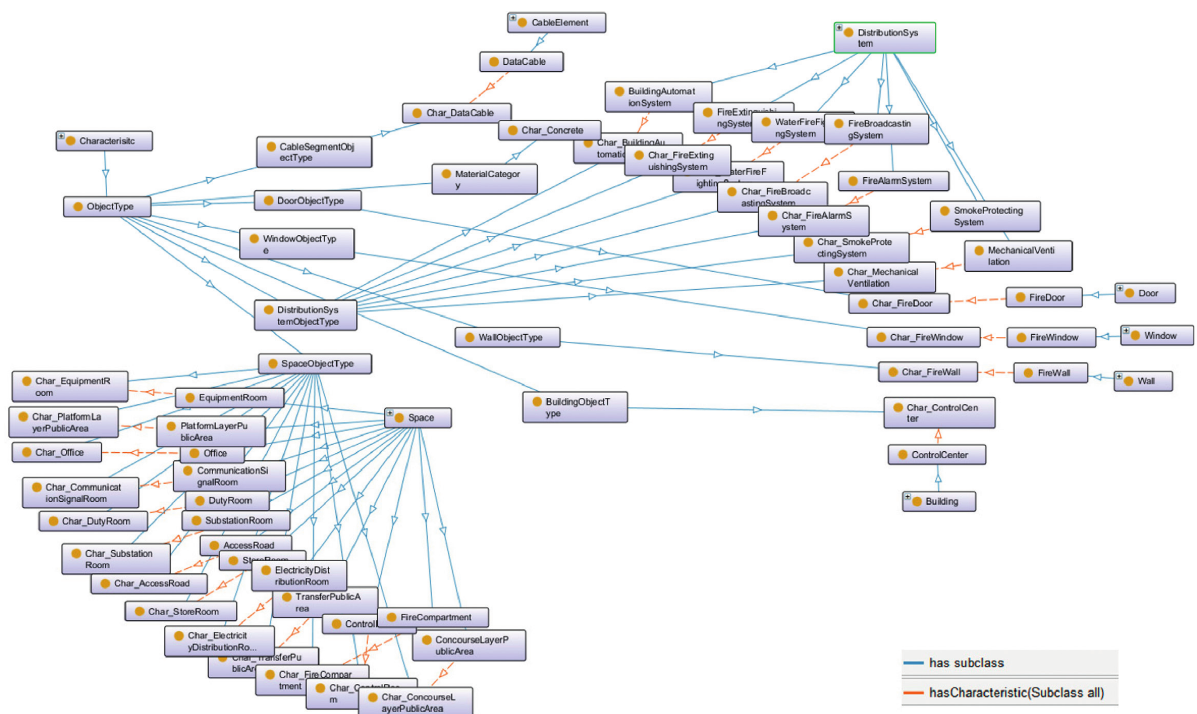
Figure 12: The extended attribute value in code ontology.